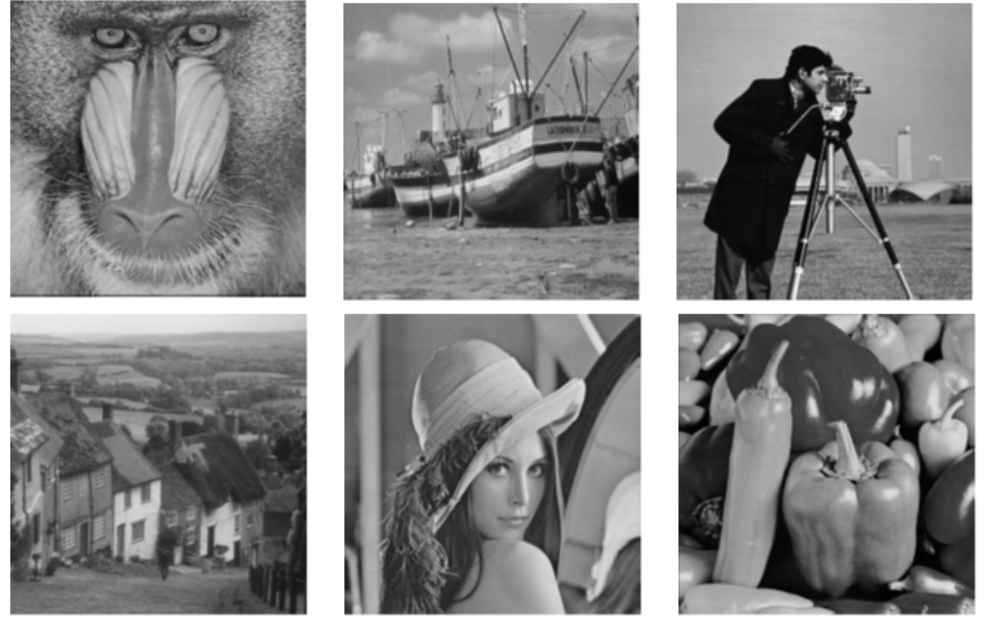
Figure 8. Cover images (512 × 512): Baboon, Boat, Cameraman, Goldhill, Lena, and Peppers.